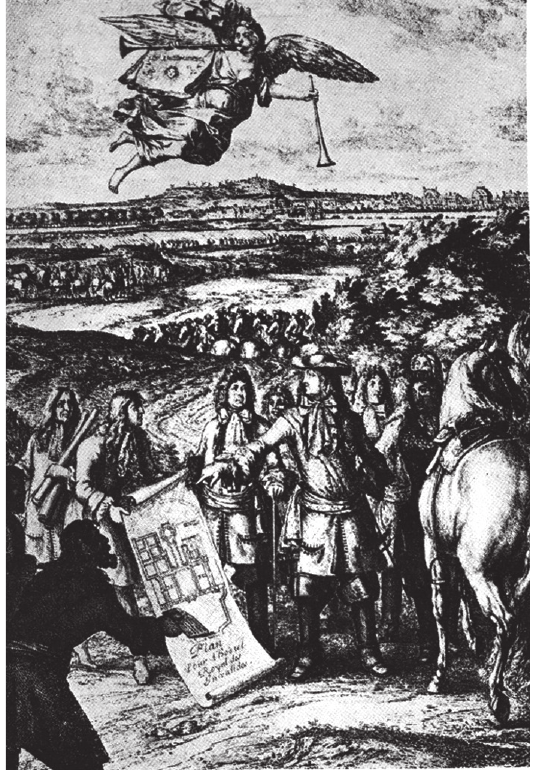
fig. 3. louis XIV ordering the construction of les Invalides, “Homage to a great urbanist” le Corbusier’s caption in le Corbusier, urbanisme,